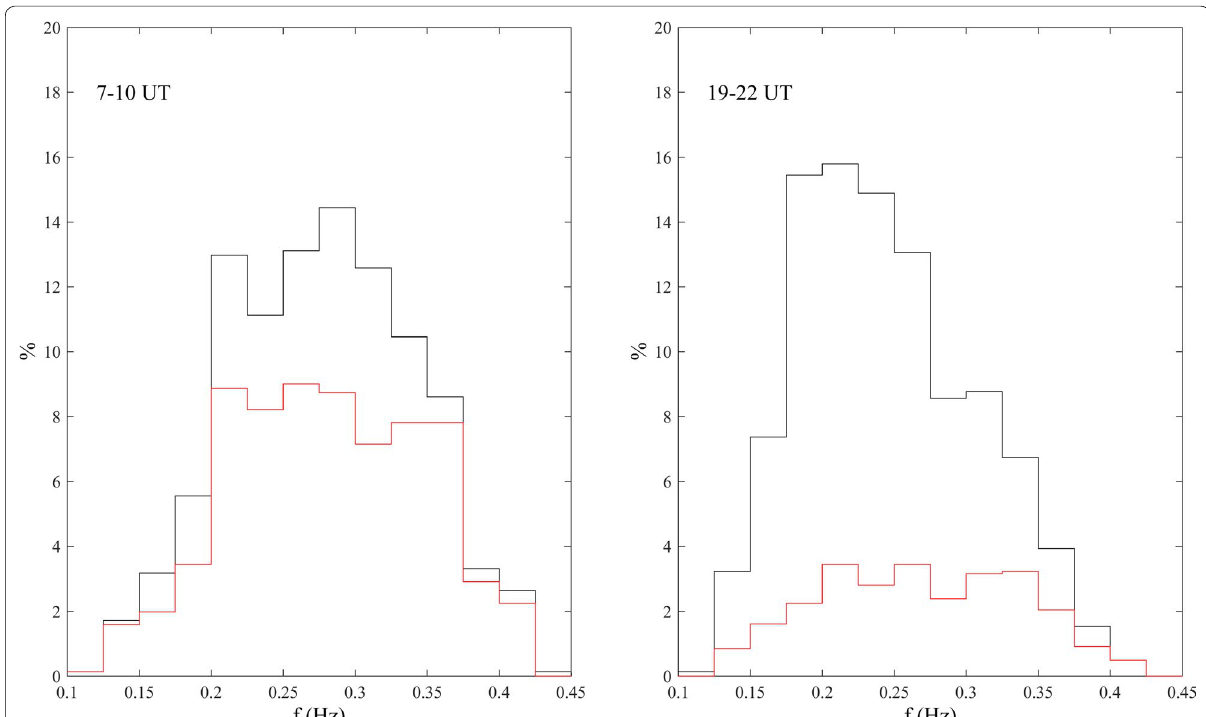
Fig. 7 Frequencies of selected events. The frequency distribution for events around magnetic local midnight (left panel) and magnetic local noon (right panel). The percentages are computed with respect to the number of events for each time interval. Red lines refer to polarized